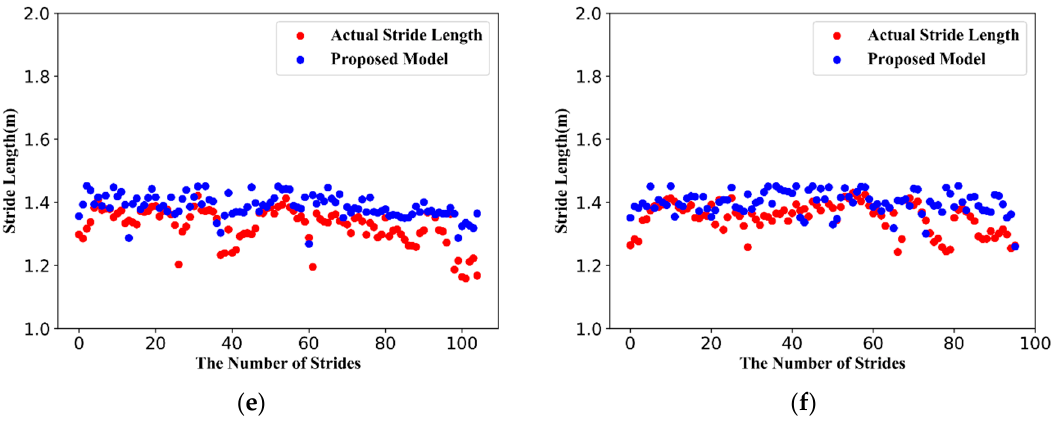
Figure 13 . Comparison of estimated stride-length and true stride-length in typical scenarios. ( a ) offices; ( b ) shopping malls; ( c ) metro stations ; ( d ) underground parking lots; ( e ) streets; ( f ) footpath.